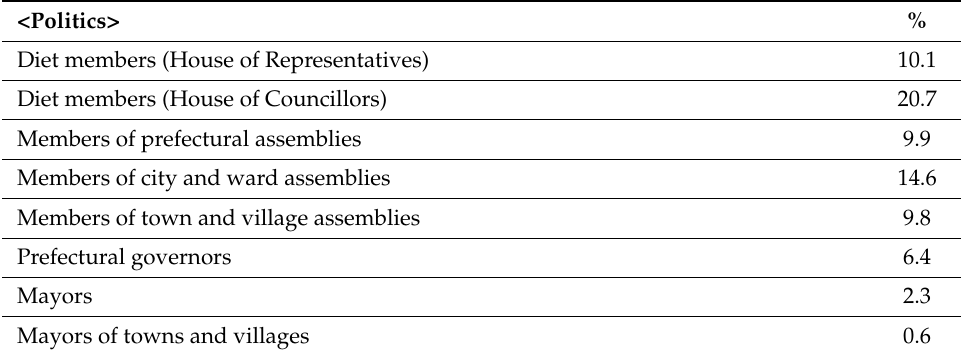
Table 1. Proportion of women in major leadership positions in various fields (unit: